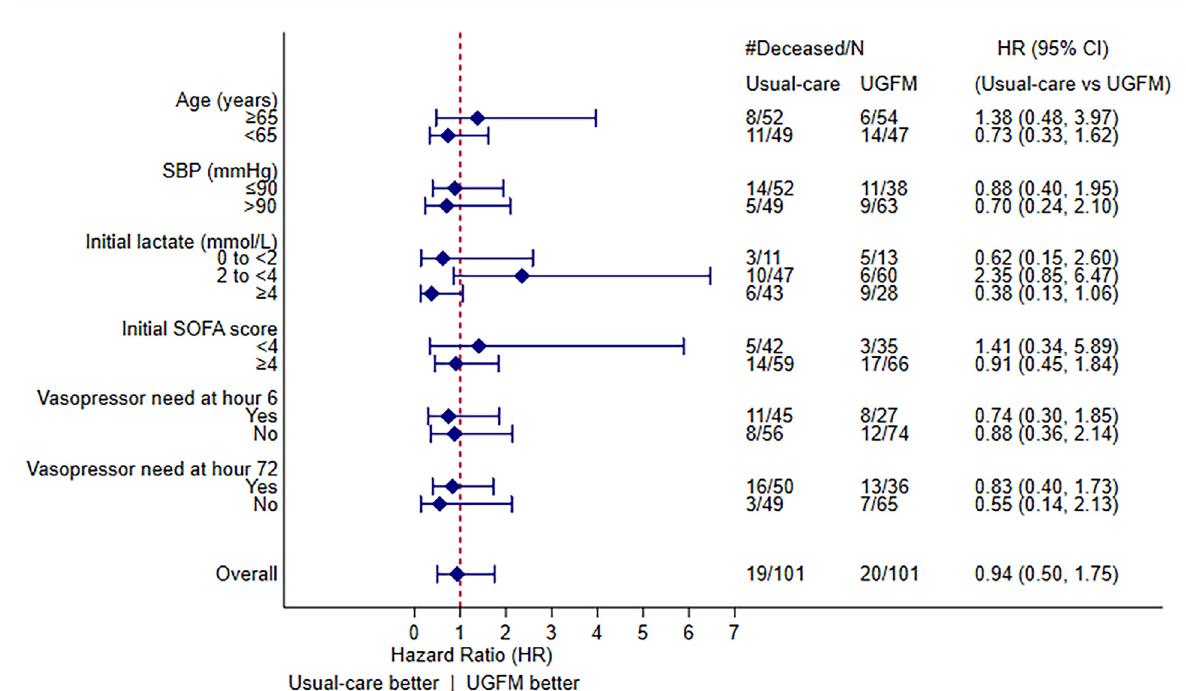
Figure 3. Forest plot for prespecified subgroup analyses of primary outcome adjusted for age, systolic blood pressure at presentation, initial lactate level, initial sequential organ failure assessment score, and vasopressor need at hour-6 and hour-72. All P-values for interaction are